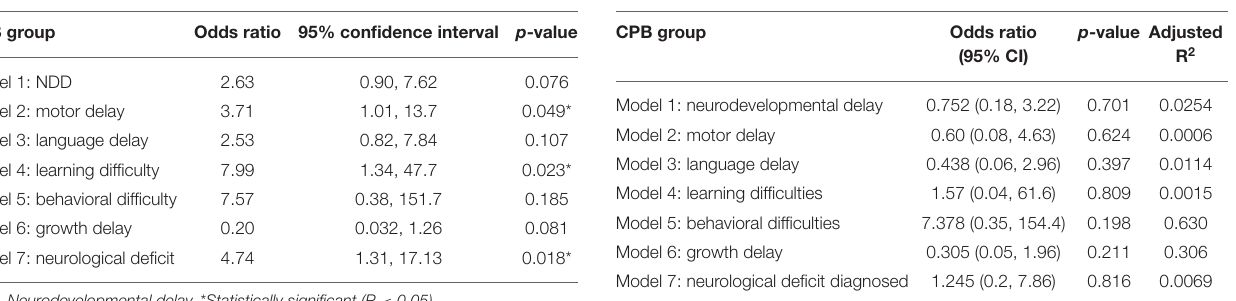
TABLE 5 | Multivariate exact logistic regression models: the effect of group allocation on neurodevelopmental